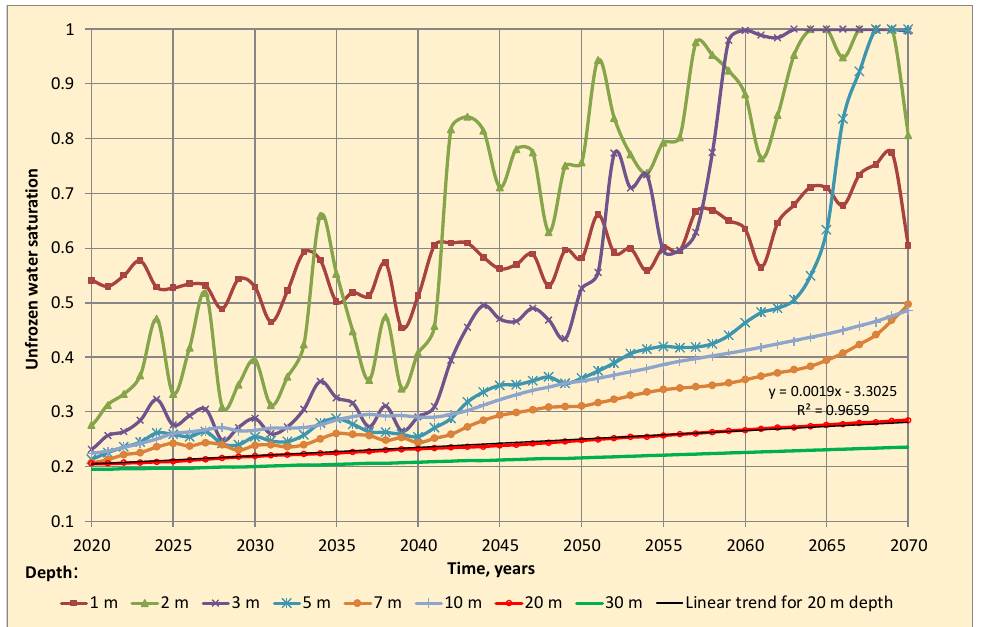
Figure 2. Forecast of the mean annual unfrozen water saturation vs. time (years) for different depths for Point “631—Marre-Sale” (Western Yamal), scenario RCP-8.5, undisturbed conditions. The new integral indicators of the state of the upper layers’ permafrost are the “Depth of permafrost table” in relation to the “Mean annual unfrozen water saturation integrated over 10-m upper layer of the ground”: index of unfrozen water saturation (IUWS). The IUWS serves as a complex characteristic of the seasonal partial freezing–thawing dynam- ics of the content of unfrozen water in the soil (Figure 3). The value of IUWS is zero in a completely frozen state without any unfrozen water, reaching 10 in ground that is in a permanently thawed state. The analysis of these dynamics is also important for under- standing the variability of the bearing capacity of the soil (Figure 4).